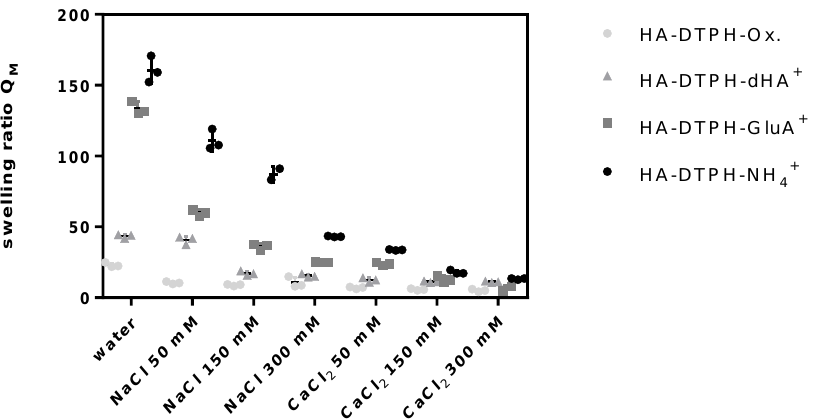
Figure A1. Swelling ratio of HA-DTPH 58% -Cl + hydrogel and HA-DTPH 58% -Ox. in water and changing ionic strength and ions.